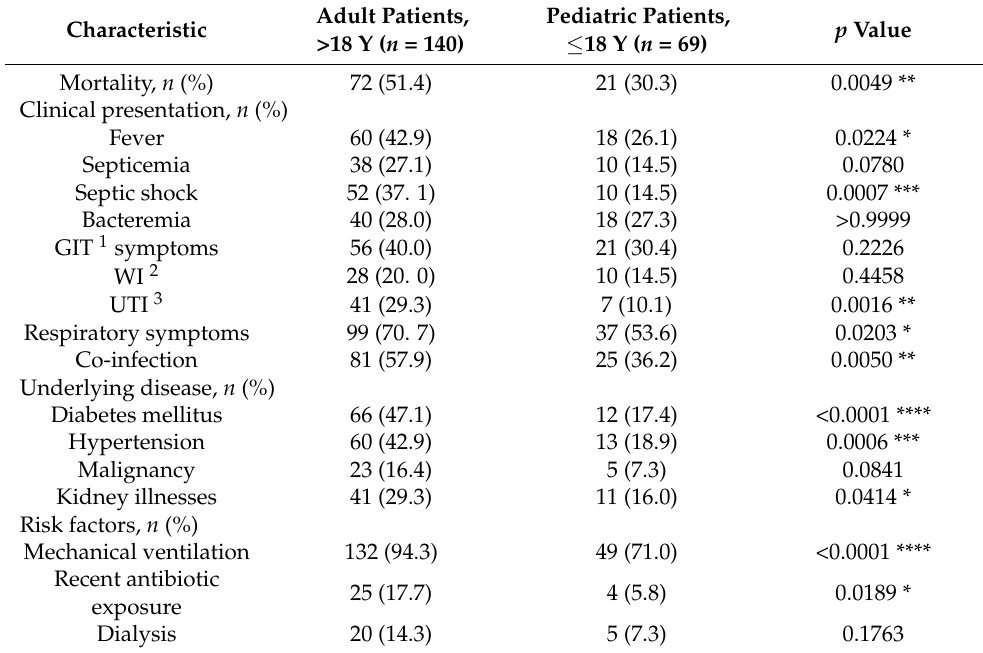
Table 2. Comparison of clinical characteristics of adult and pediatric ICU patients with S. maltophilia